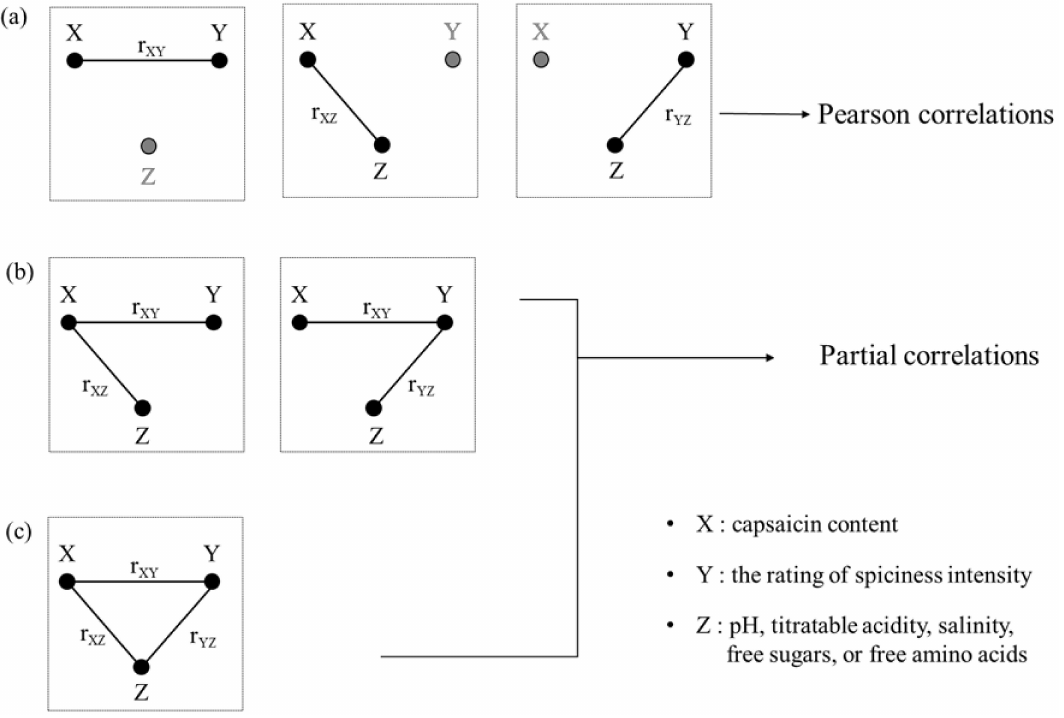
Figure 4. Graphical illustration of Pearson’s and partial correlations among the three random variables X, Y, and Z: ( a ) Pearson correlations; ( b ) and ( c ) partial